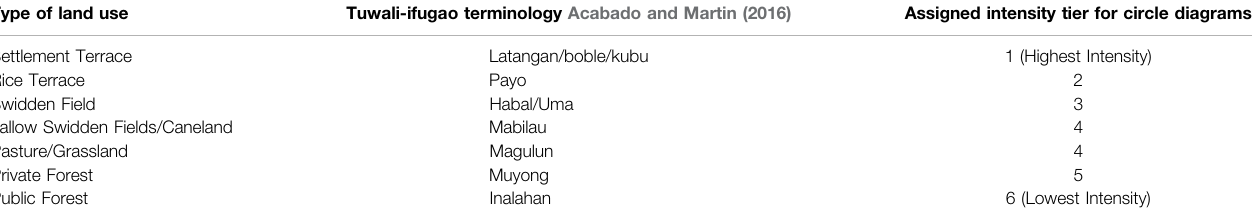
TABLE 1 | Ifugao land use terminology as it applies to our land use modelling. The leftmost column names seven types of land use typical to Ifugao. The middle column provides the Tuwali-Ifugao (Kiangan Region) terms for these forms of land use (Acabado and Martin, 2016). The rightmost column assigns each form of land use to an Intensity Tier, re fl ecting how transformative of the landscape that activity is relative to others. These Intensity Tiers determine where each form of land use is depicted on a circlediagram.ThistableisinspiredbysimilartablespresentedinConklin ’ s EthnographicAtlasofIfugao (1980)anduseshisterms, “ Grassland ” and “ Caneland, ” todescribe fi elds overtaken by primary and secondary growth.